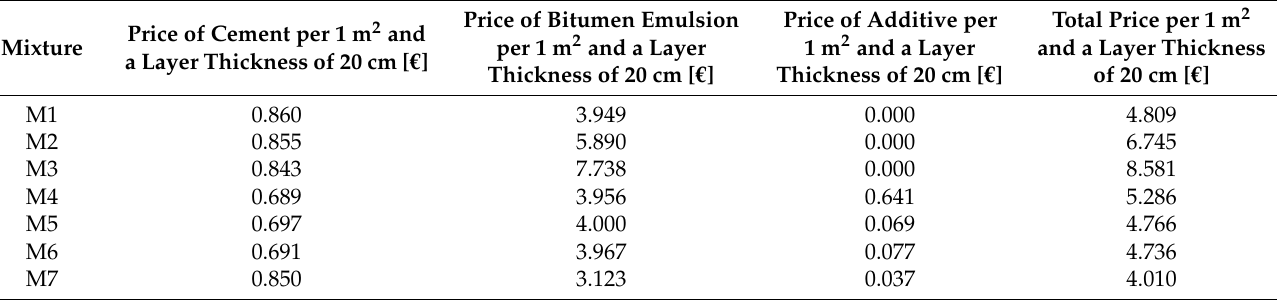
Table 9. Information about price of